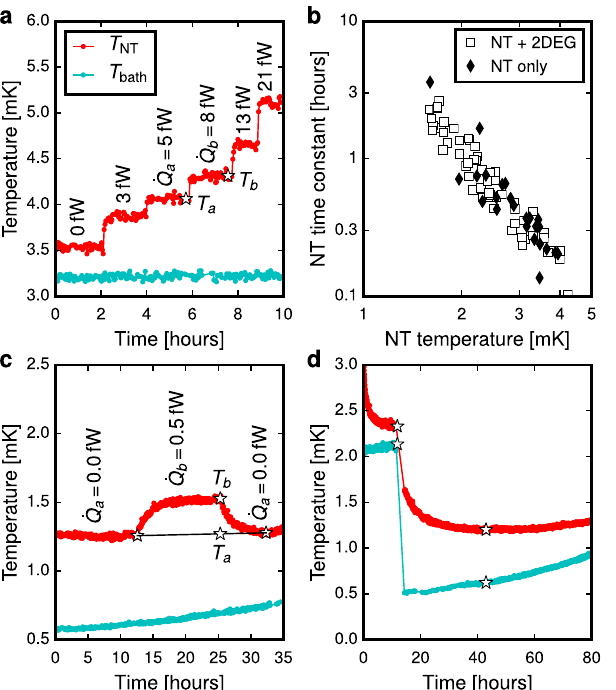
Fig. 5 Measurements of the thermal conductance and heat leak. a The thermal conductance G Σ was inferred from the step-wise measurement of T ð _ Q J Þ when T bath was kept constant. b The slow response of NT NT heaters and T bath below 3 mK required a modi fi ed G Σ measurement shown in ( c ). d Heat leak was inferred via stationary Eq. (3) which applies when dT dt = NT /